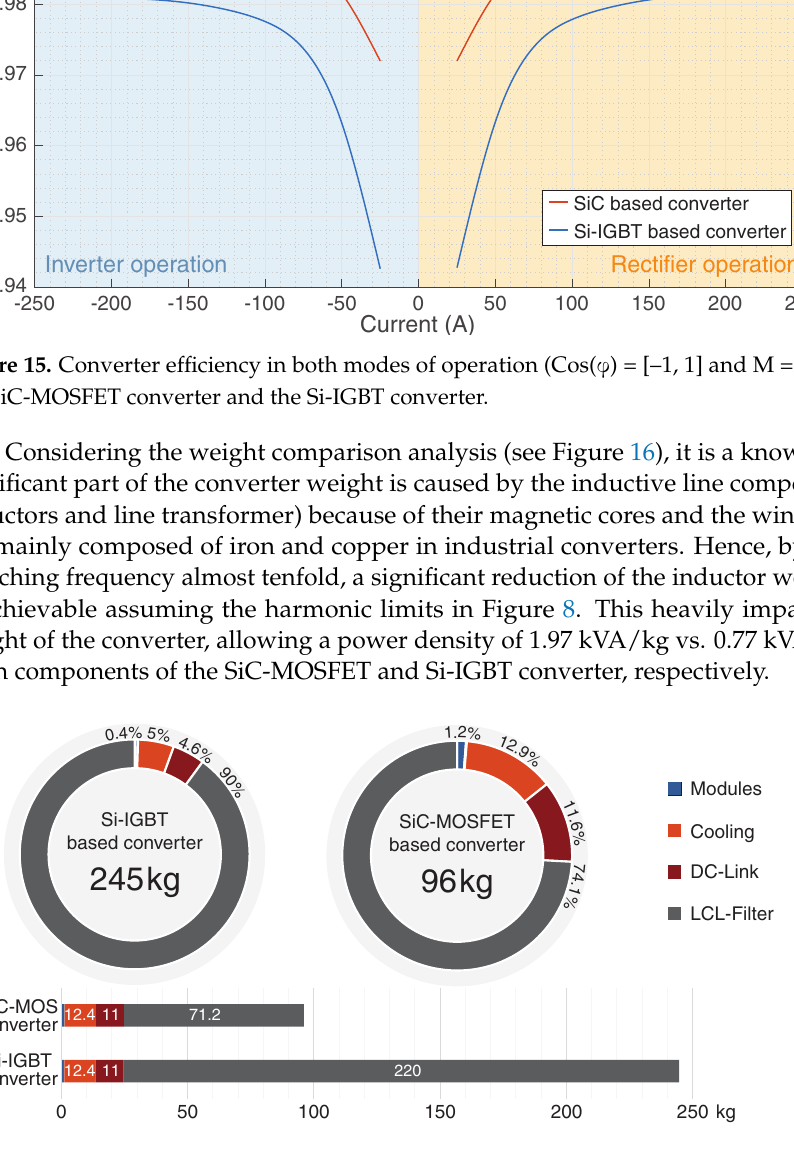
Figure 16. Comparison of percentage and total weight distribution of both converter